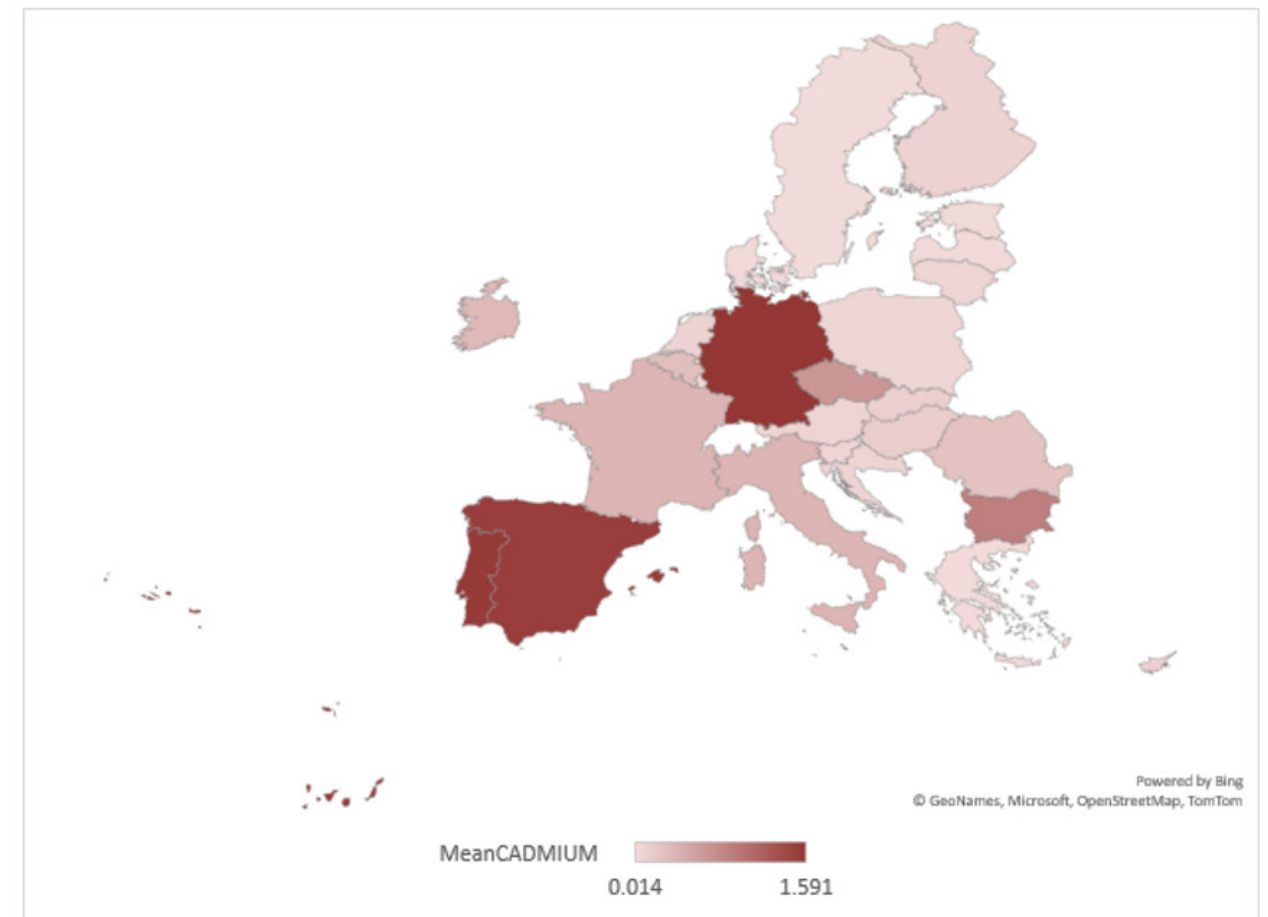
Figure 7. Disparities in policies to combat cadmium water pollution in the EU. At the European level, according to official data, between 2000 and 2021, the highest pollution levels were recorded on average in countries such as Germany, Spain and Por- tugal, while the opposite was true for Greece and Sweden. As cadmium directly affects the health of the aquatic environment, in many EU member countries, increased concen- tration levels lead to adverse eutrophication effects. This has changed the composition of bottom communities, leading to a reduction in fish and aquatic animal populations. In the less polluted areas of the Nordic countries, cadmium concentrations are as low as 10% and have led to increased trade in fish products amid growing global consumer confi- dence in the health and food safety of fish products from these regions. In contrast, there has been a decline in consumer confidence in fish products from the countries most af- fected by cadmium pollution (species such as mussels). In the case of lead water pollution, the average pollution map based on official re- ports [46] is shown in Figure 8.